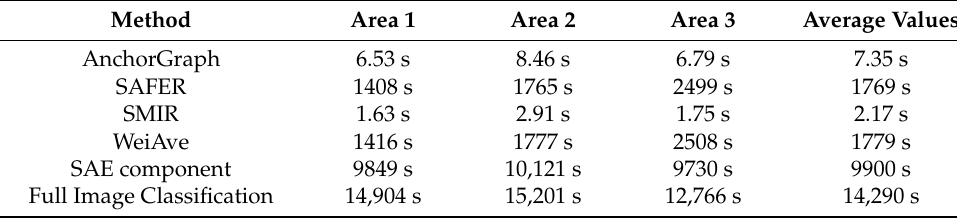
Table 6. Computational cost of several components of our